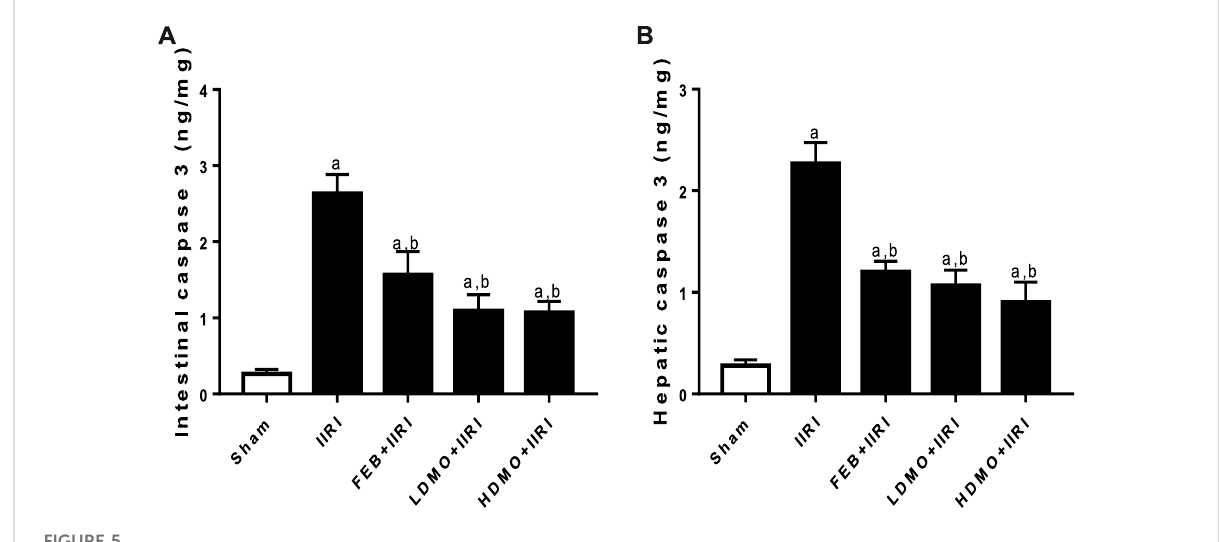
FIGURE 5 Effect of intestinal ischaemia/reperfusion (I/R) and methanolic Moringa oleifera leaf extract on caspase 3 activities in the intestinal and hepatic tissues. IIRI: Intestinal ischaemia/reperfusion injury, FEB: febuxostat, LDMO: low dose Moringa oleifera, HDMO: high dose Moringa oleifera, a p